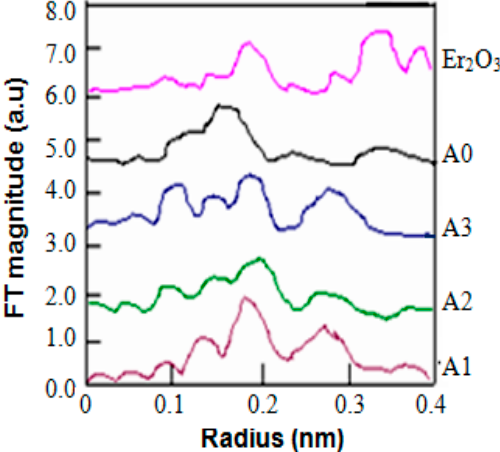
Figure 18. Radial distribution function of three EDFs (A1, A2, and A3) containing different contents of Al 2 O 3 and Er 2 O 3 , along with one EDF sample without Al 2 O 3 (A0).